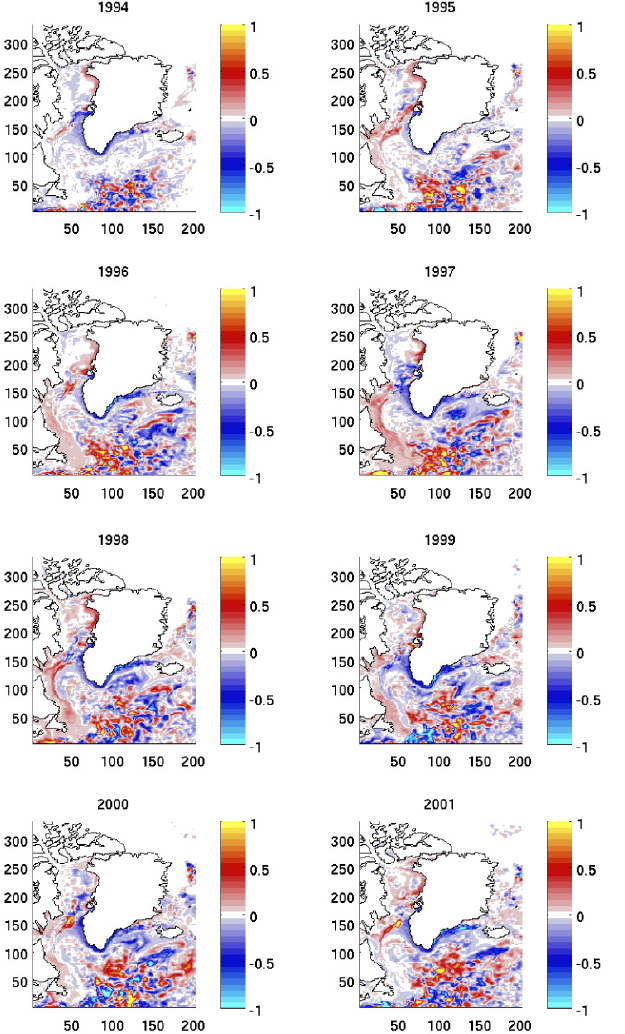
Fig. 10. Annual mean 106m salinity anomalies (psu) for the period